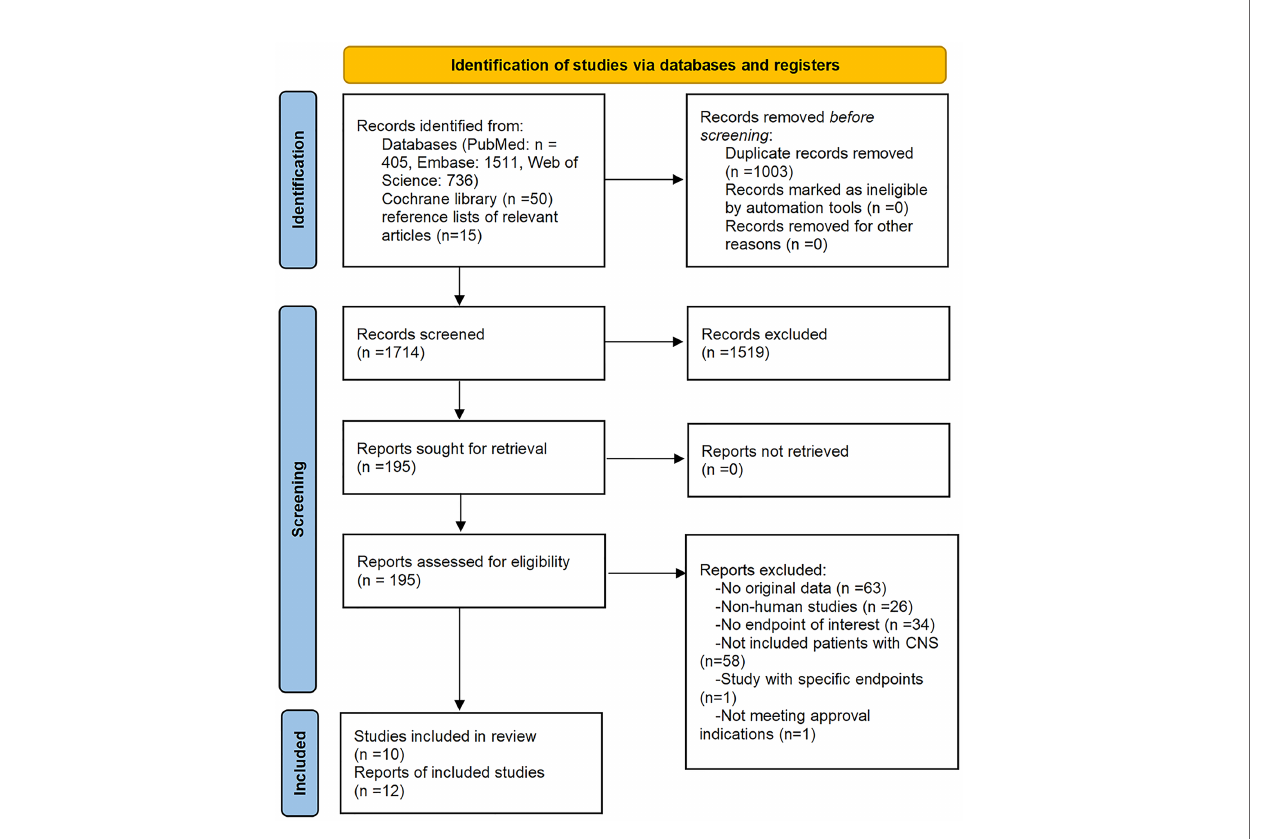
FIGURE 1 | Flow diagram of the study select